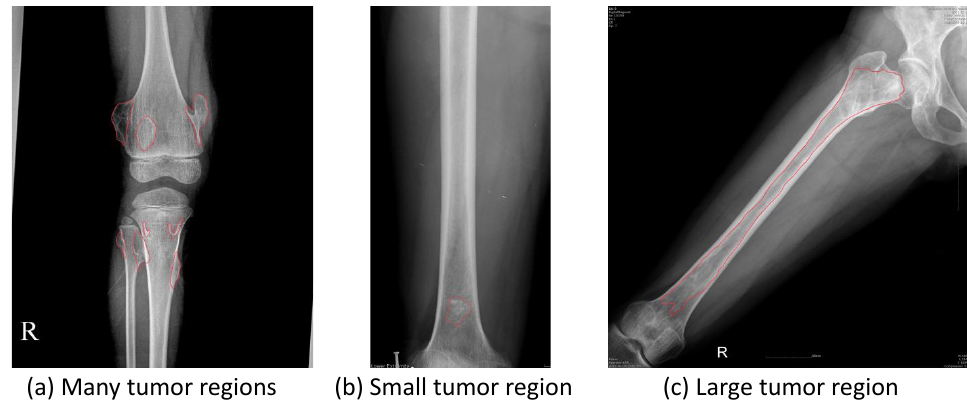
Figure 5. Difficult tumor images in CNUH dataset. The red lines are the ground-truths drawn by the CNUH physicians. These sample images show common challenges in the CNUH dataset such as ( a ) diversity of tumor occurrence, ( b ) too small size of tumor region, and ( c ) too large size of tumor region and pose